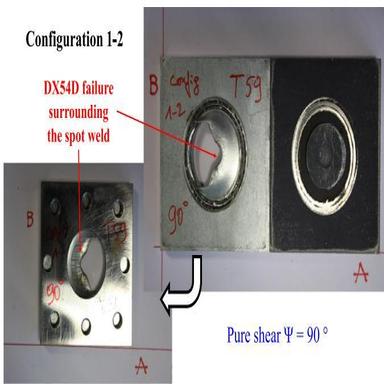
Failure mode for the pure shear test in configuration "1-2" (ψ = 90∘ ).